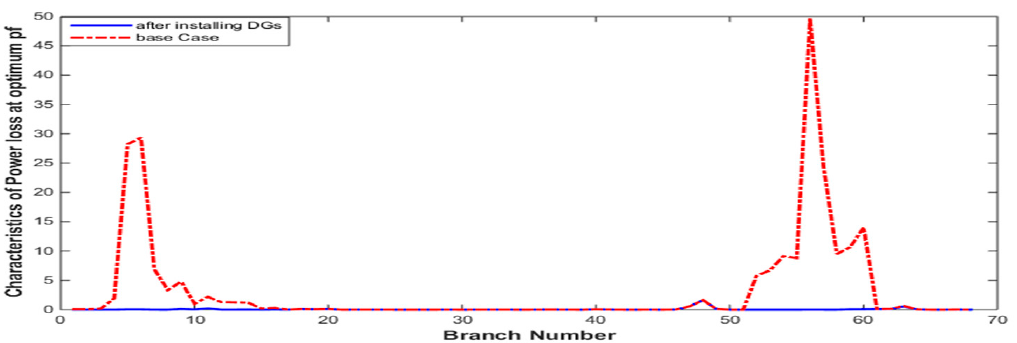
Energies 2020 , 13 , x FOR PEER REVIEW Figure 29. Characteristics at power loss at optimum pf. Figure 29. Characteristics at power loss at optimum pf.